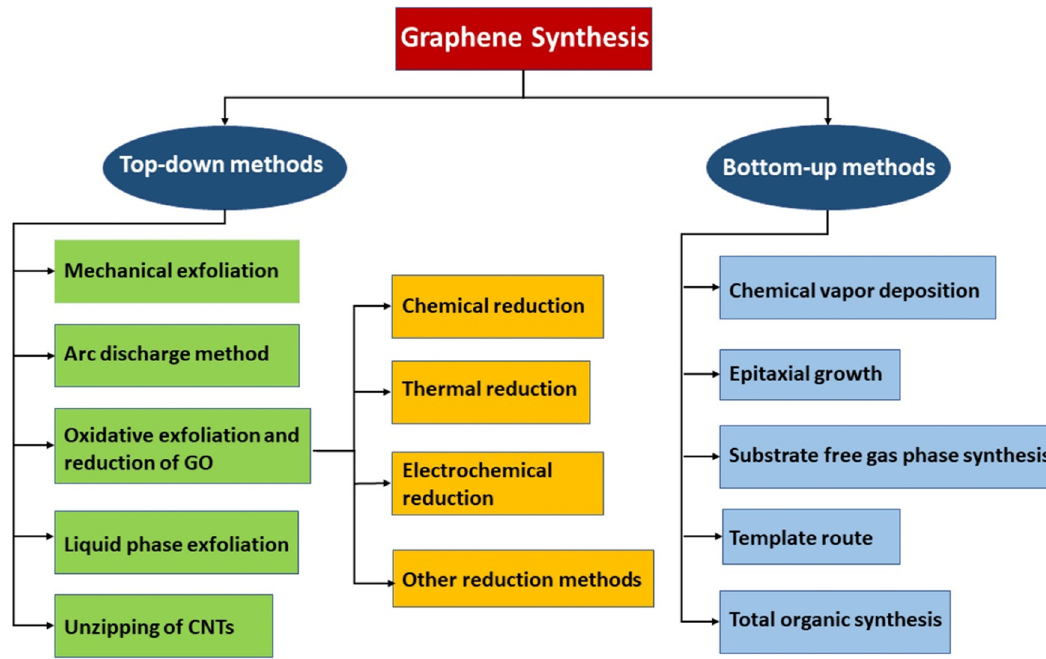
Figure 6: Classi fi cation of synthetic routes for graphene - based materials [ 43 ]